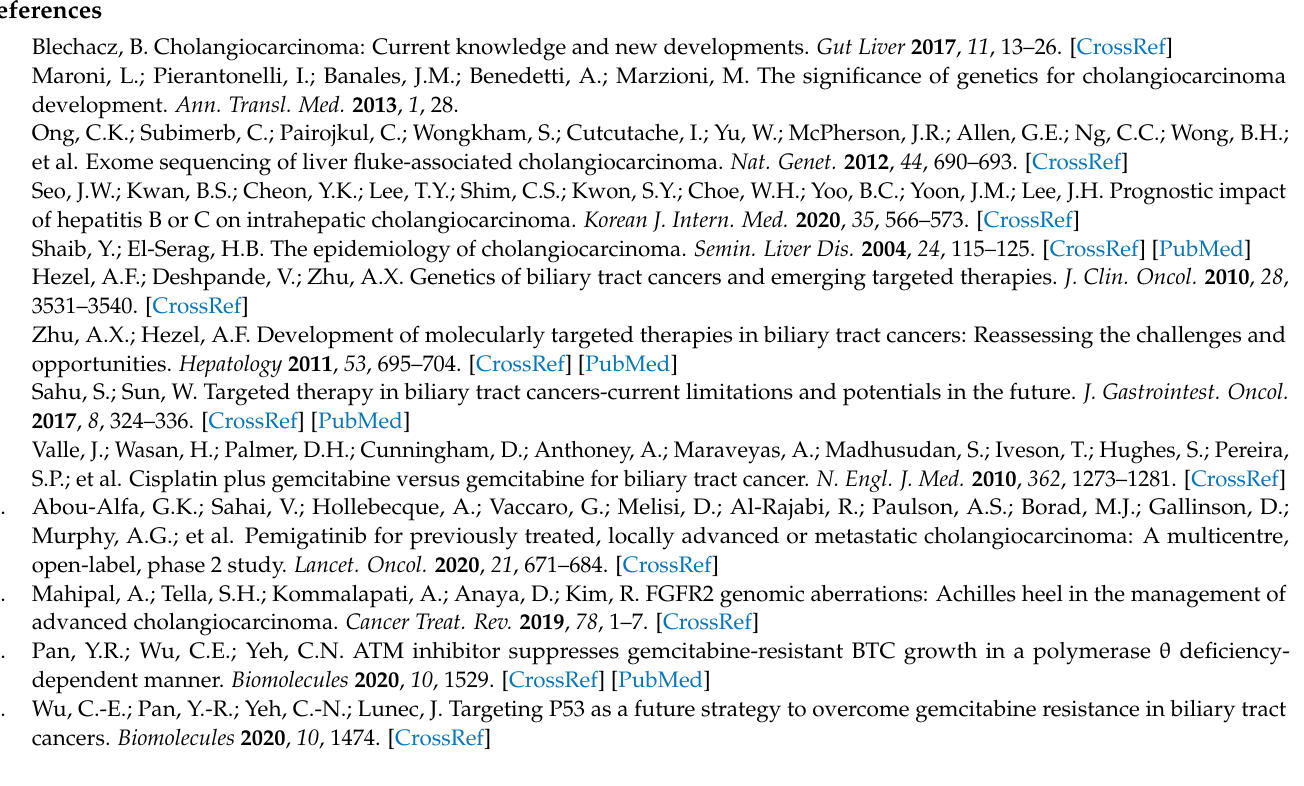
Table S2. RNA sequencing identified 21 significantly up-regulated genes and five downregulated genes following indicated